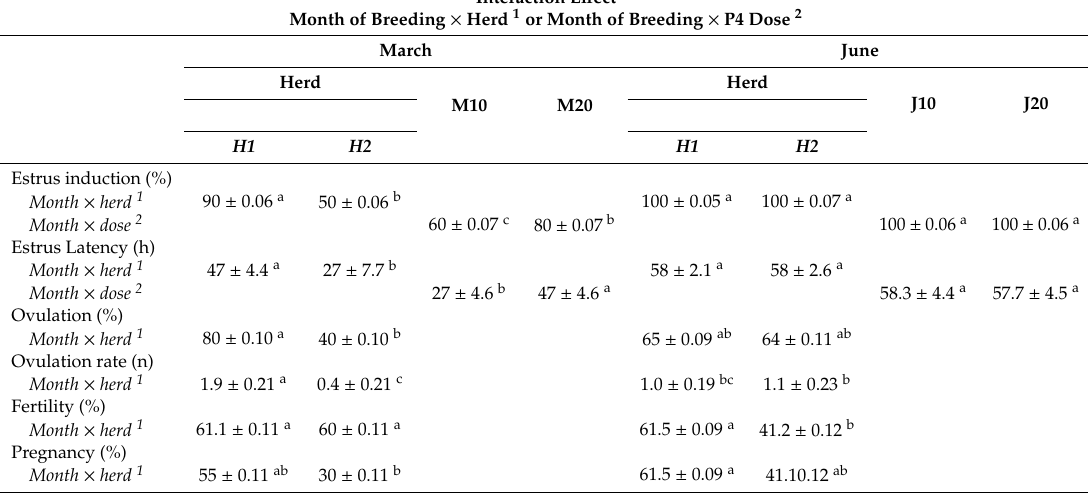
Table 3. Least square means for estrus induction, estrus latency ovulation, ovulation rate, fertility, pregnancy, and some three order interactions in adult–anestrous crossbred (Saanen-Alpine-Nubian x Criollo) goats exposed to an ultra–short P4 & eCG based estrus induction protocol and breed either in March or June and using two P4 doses (i.e., 10 or 20 mg) in two commercial herds in Mexico (25 ◦ N).